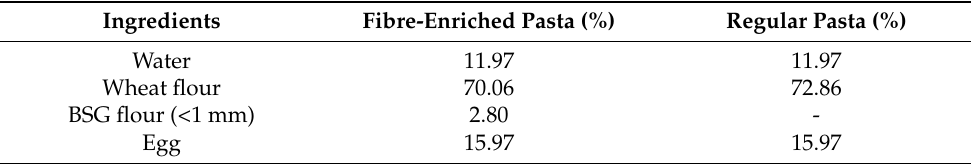
Table 2. Formulations of fibre-enriched pasta and regular pasta.